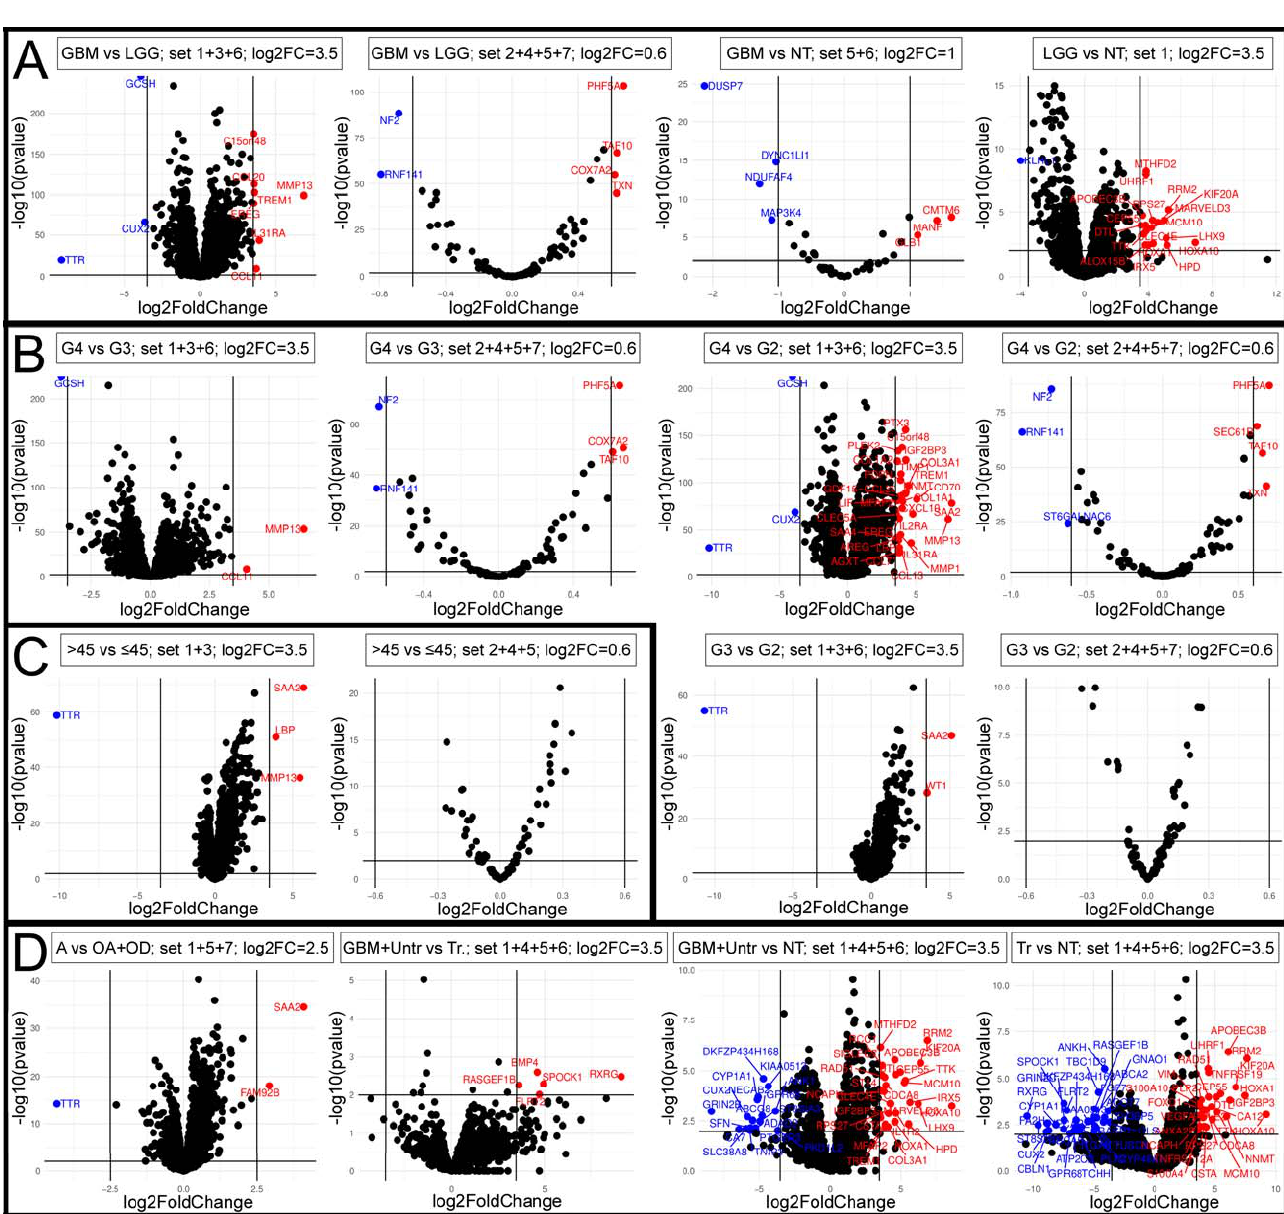
Figure 4. Differential gene expression analysis for each comparison. ( A ) Comparisons of tumor_type . ( B ) Comparisons of neoplasm_histologic_grade . ( C ) Comparisons of age_at_initial_pathologic_diagnosis. ( D ) Comparisons of histological_type . Genes marked with blue are downregulated while those in red are